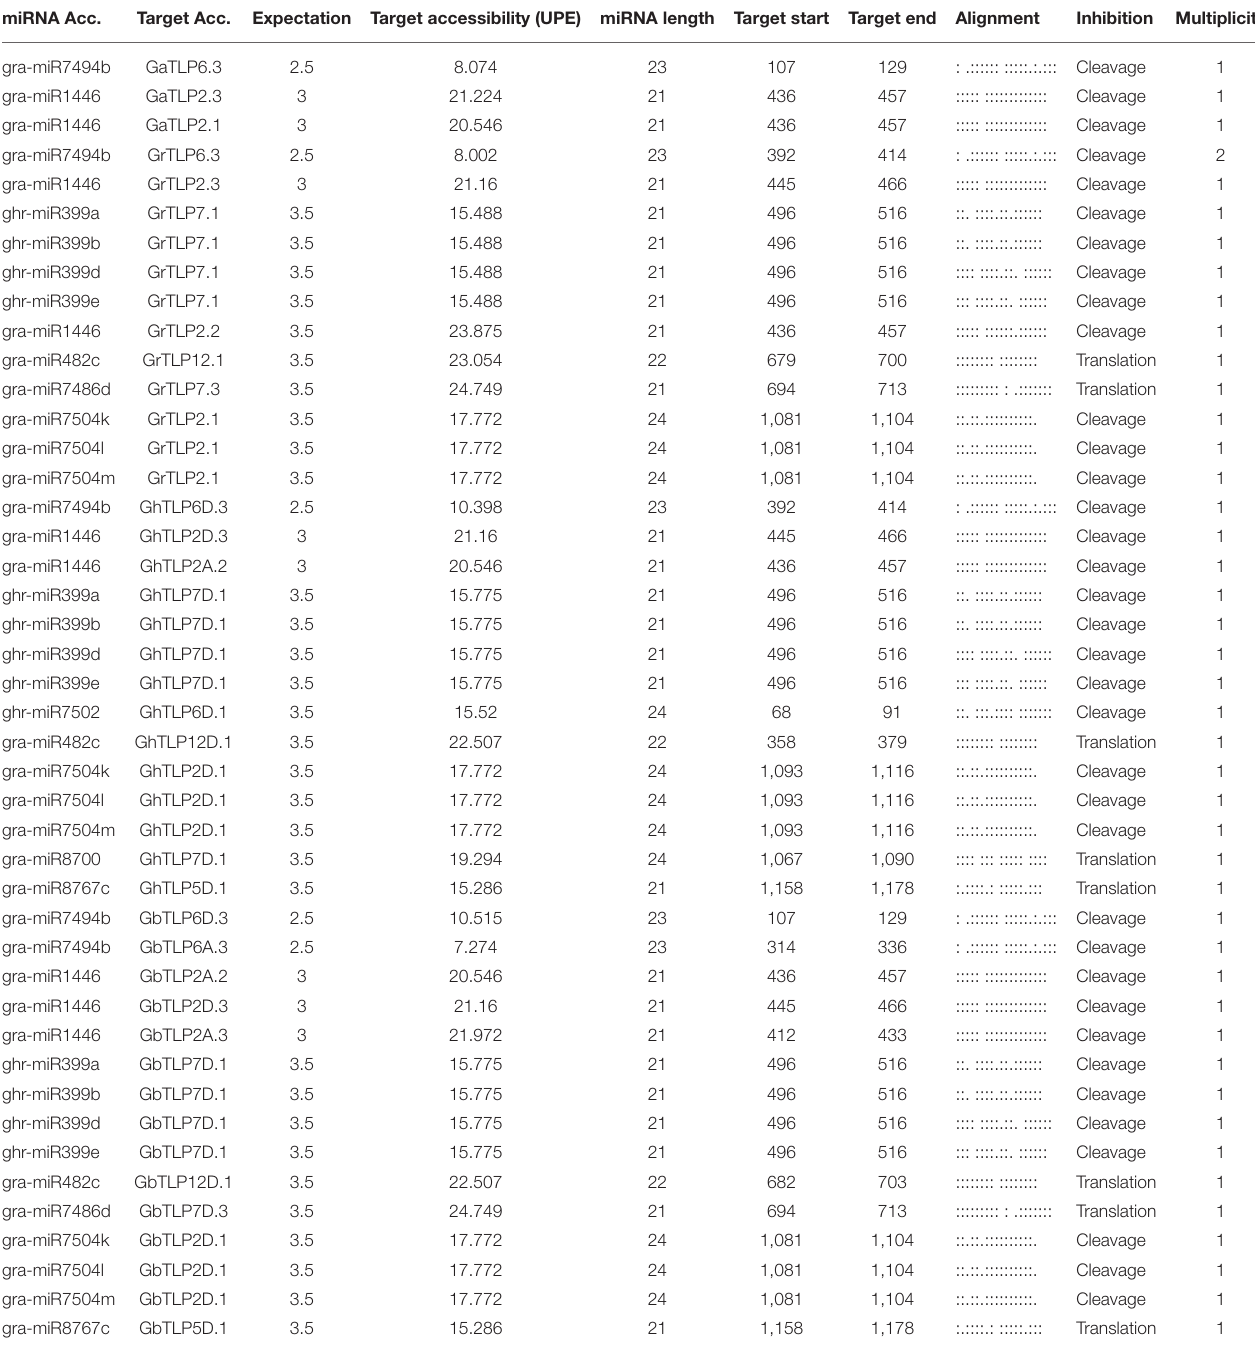
TABLE 4 | The potential miRNA target sites in cotton TLP transcripts. miRNA